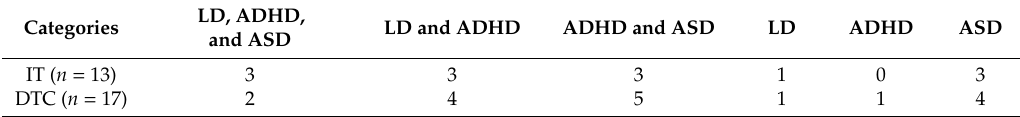
Table 2. Target students’ di ffi cult tendencies related to developmental disorders 1.